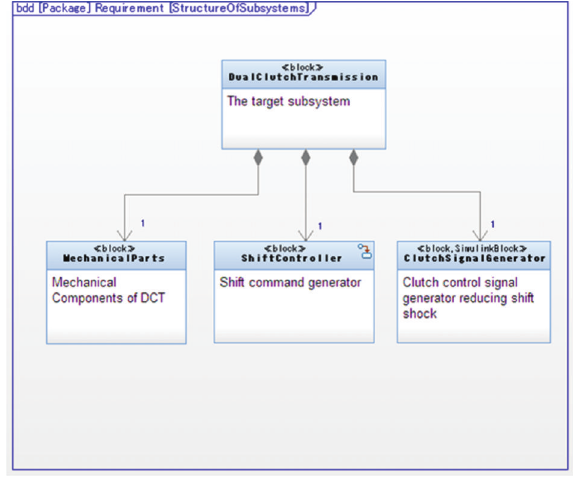
Figure 10: System